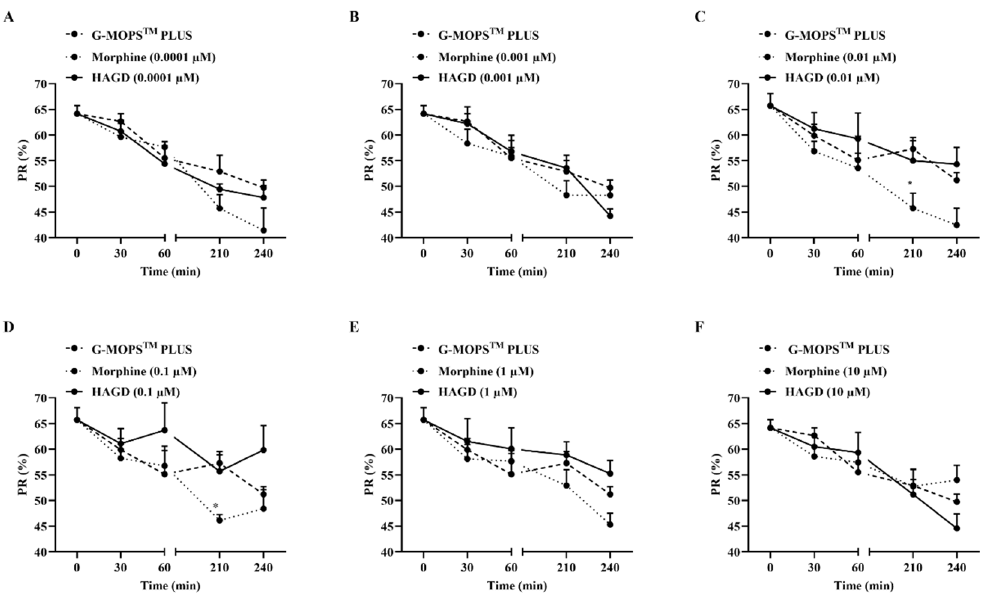
Figure 5. Evaluation of the effects of HAGD on sperm motility ( n = 5 for each drug concentration). ( A ) To evaluate the effect of 0.0001 µ M of HAGD on sperm motility. ( B ) To evaluate the effect of 0.001 µ M of HAGD on sperm motility. ( C ) To evaluate the effect of 0.01 µ M of HAGD on sperm motility. ( D ) To evaluate the effect of 0.1 μ M of HAGD on sperm motility. ( E ) To evaluate the effect of 1 μ M of HAGD on sperm motility. ( F ) To evaluate the effect of 10 μ M of HAGD on sperm motility. * p < 0.05 indicates significant differences compared with the G-MOPS TM PLUS group, according to two-way analysis of variance, followed by Bonferroni’s post hoc test. Drug dosage was in μ mol/L for each sperm sample. PR, progressive motility.